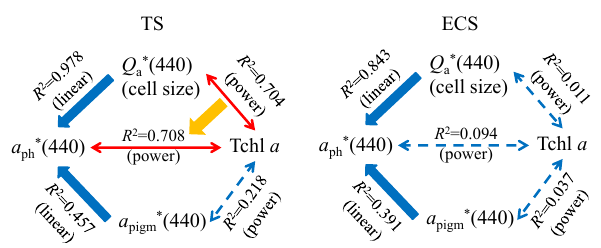
Fig. 9. Summary of the relationships among a ∗ a ∗ (440), and Tchl a in the Tsushima Strait (TS) and East China pigm Sea